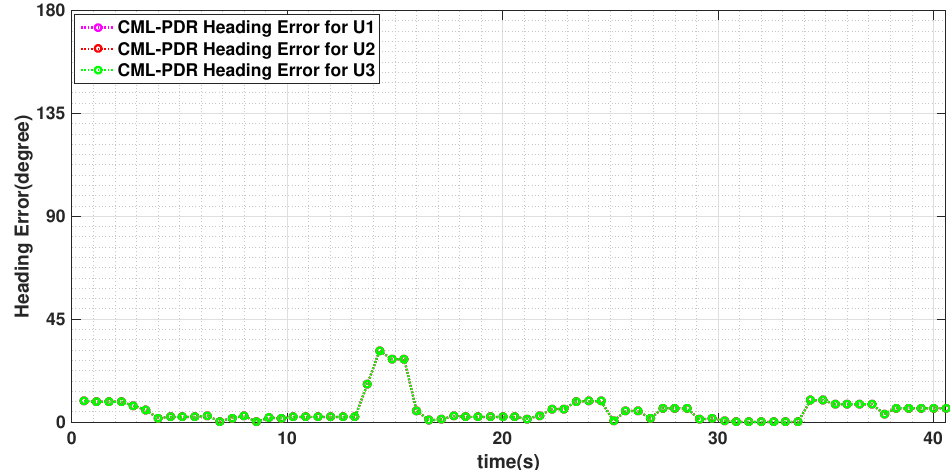
Figure 10. Heading estimates of three users using CML-PDR. The pedestrians walk in different speed and over the square path 3 turns shown in Figure 11. Since all the users collaborate to estimate consensus heading, all three users have the same heading error.